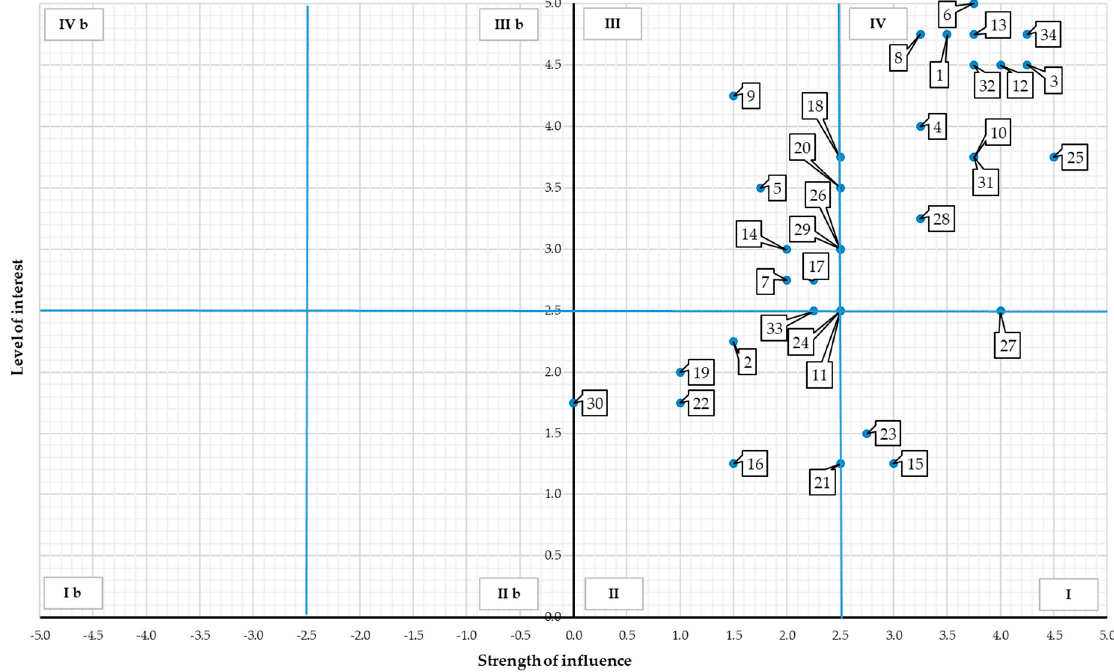
Figure 8. Stakeholder map in the knowledge ecosystem: strength of influence—level of interest.